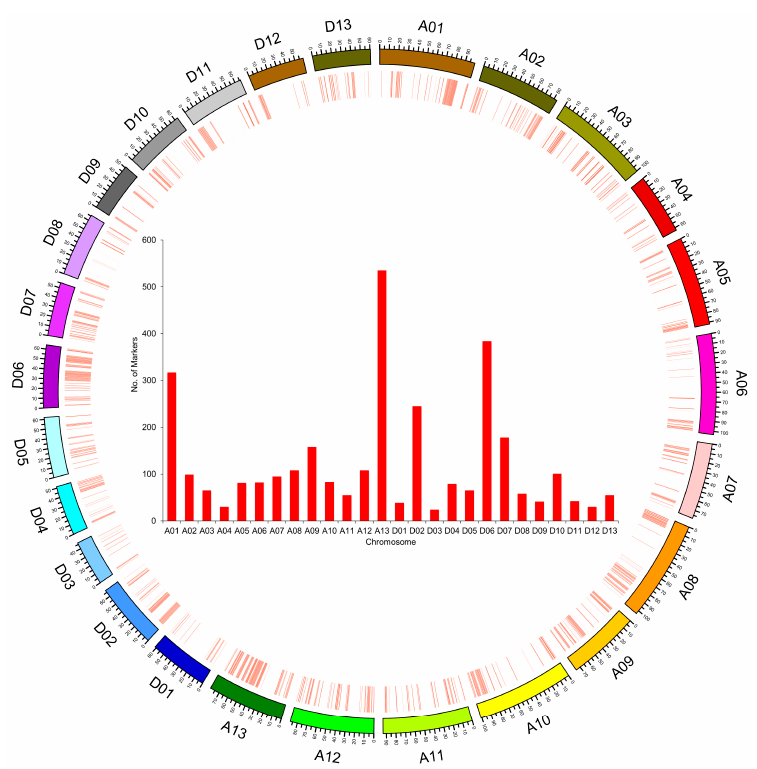
Figure 3. Number of markers in chromosomes. Inside the circle, x axis indicates the chromosomes and y axis indicates the number of markers. Markers with their positions are assigned to respective chromosomes differentiated by colors.